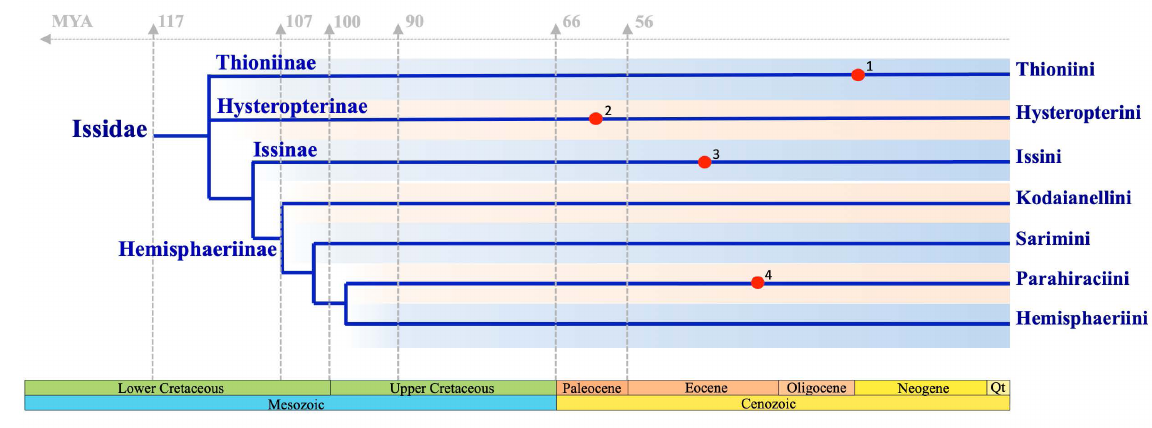
Fig. 3. Current phylogeny of Issidae, modified from Wang et al. (2016) according to Zhao et al. (2019) and labelled with molecular calibration data from Bourgoin et al. (2018). Red dots refer to the fossils known with their minimal age according to their deposit. 1 . Thionia douglundbergi Stroinski & Szwedo, 2008 (15.97 Ma). 2 . Cubicostissus palaeocaeni gen. et sp. nov. (60 Ma). 3 . Issites glaber Haupt, 1956 (42.5 Ma). 4 . Bolbossus bervoetsi (Gnezdilov & Bourgoin, 2016) (33.9 Ma). Priabonian fossils from the Isle of Wight (Szwedo et al. 2019) remain incertae sedis and are not